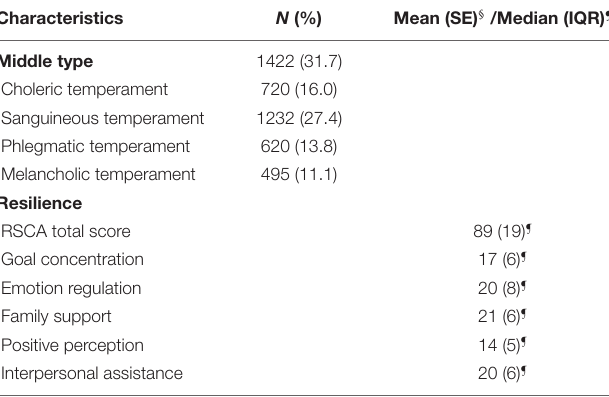
TABLE 1 | General characteristics of 4,489 study subjects.